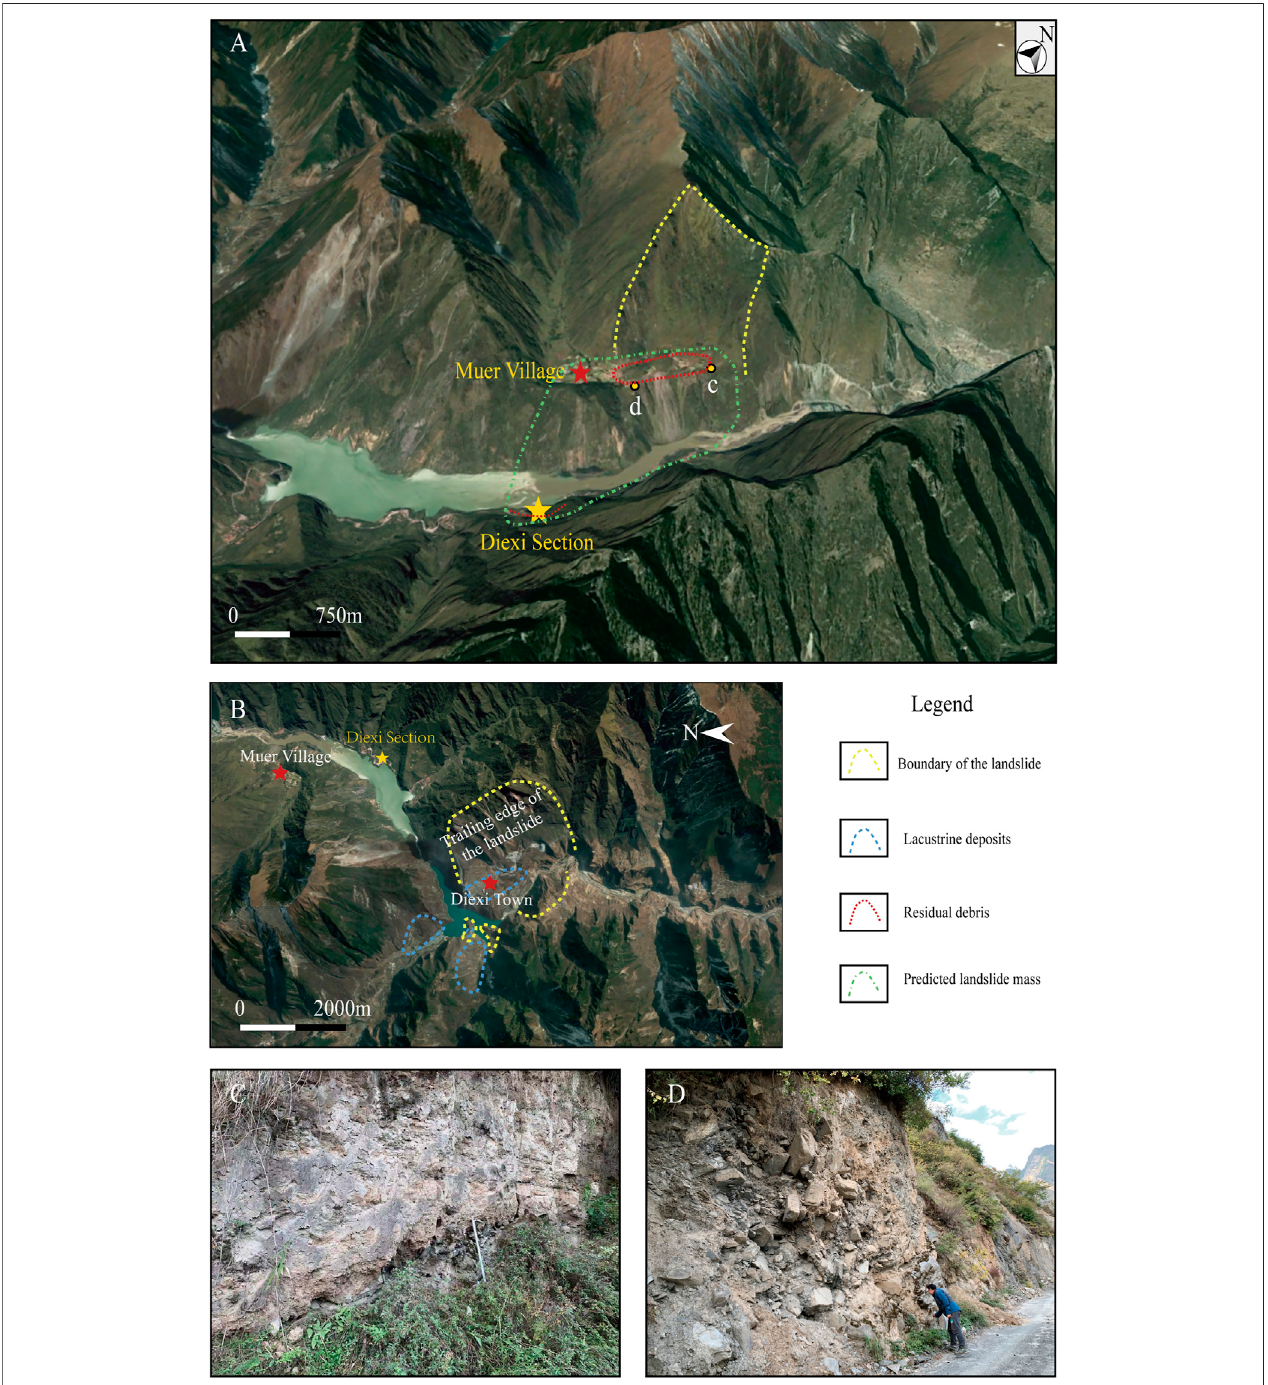
FIGURE7|(A) Muerlandslide.Theyellowdottedlinerepresentsthesurfaceoftheancientlandslide,thereddottedlinerepresentstheresidualdebris,andthelight greendottedlinerepresentsthelikelysizeofthelandslide. (B) Jiaochanglandslide(Maetal.,2018). (C) and (D) Gravellayerandlacustrinelayerlocatedontheplatformof Muer village. The base map was taken from Google Earth.